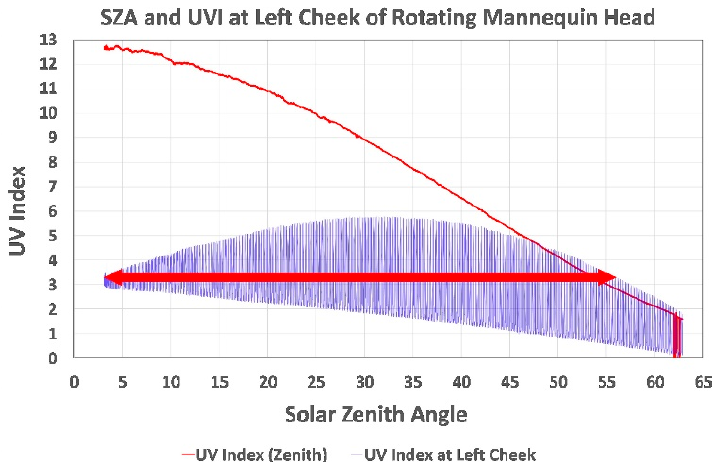
Figure 7. Horizontal UVI and UVI measured by the left cheek sensor plotted against the morning solar zenith angle (SZA) at the Old Kona Airport Park on 22 July 2018. The bidirectional arrow indicates that the left cheek received more UVR than at solar noon from a SZA of from 56° to 3°.